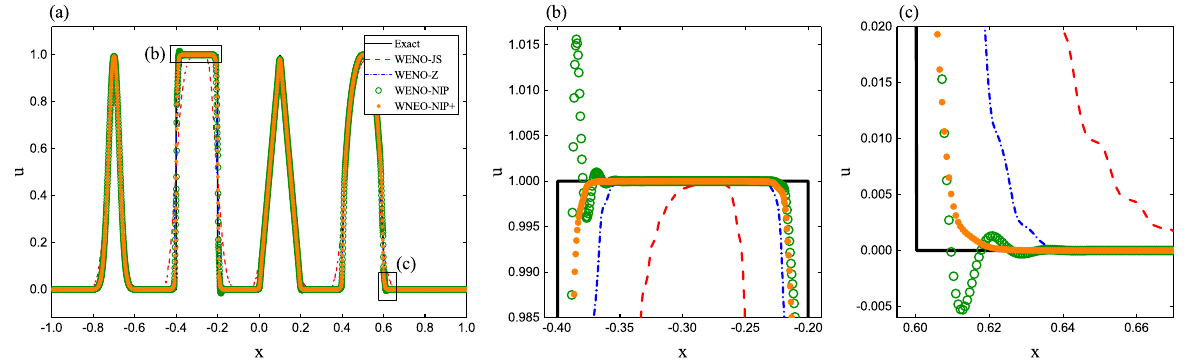
Figure 4. ( a ) Results of the Gaussian-square-triangle-ellipse linear test with t = 200 (100 cycles) and N = 1600. ( b ) Zoomed-in view of the top of the square wave. ( c ) Zoomed-in view of right bottom of the ellipse wave.